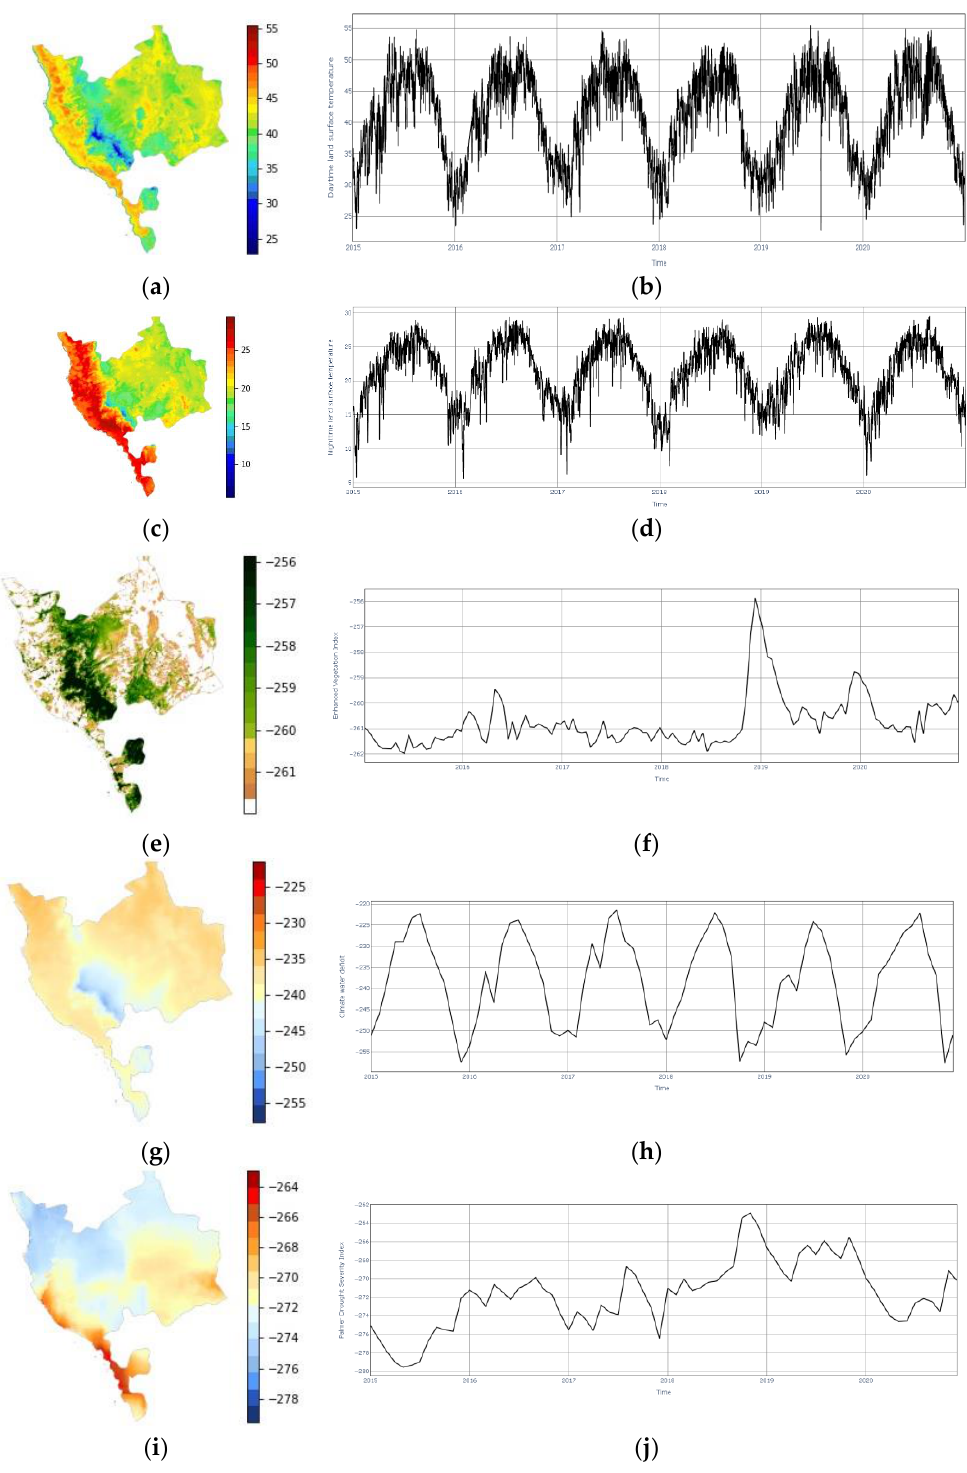
Figure 5. Samples of the dataset used in this study; ( a ) image of daytime land surface temperature of Makkah province, ( b ) timeseries of the daytime land surface temperature of Makkah province, ( c ) image of nighttime land surface temperature of Makkah province, ( d ) timeseries of the nighttime land surface temperature of Makkah province, ( e ) image of EVI of Makkah province, ( f ) timeseries of EVI of Makkah province, ( g ) image of CWD of Makkah province, ( h ) timeseries of CWD of Makkah province, ( i ) image of PDSI of Makkah province, ( j ) timeseries of PDSI of Makkah province.